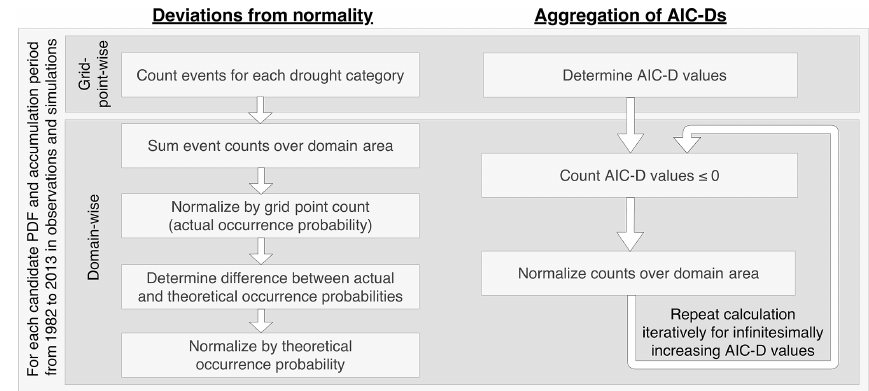
Figure 2. Flow chart of methods to aggregate deviations from N 0 , 1 (left) and AIC-D frequencies (right) over